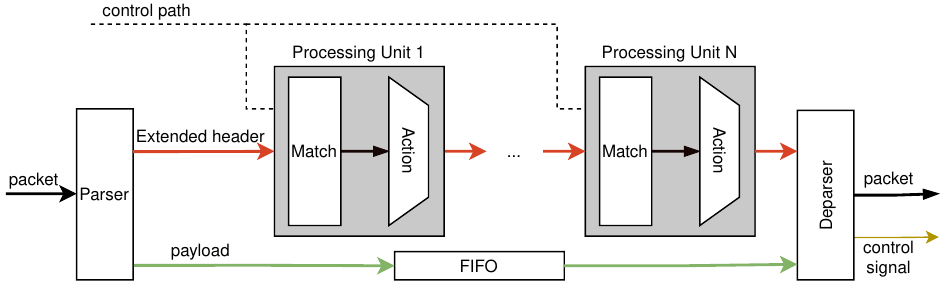
Figure 2. The reprogrammable match-action